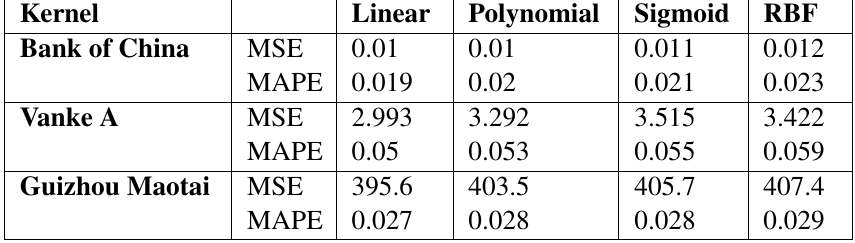
Table 3 Comparison of four kernels in SVMR